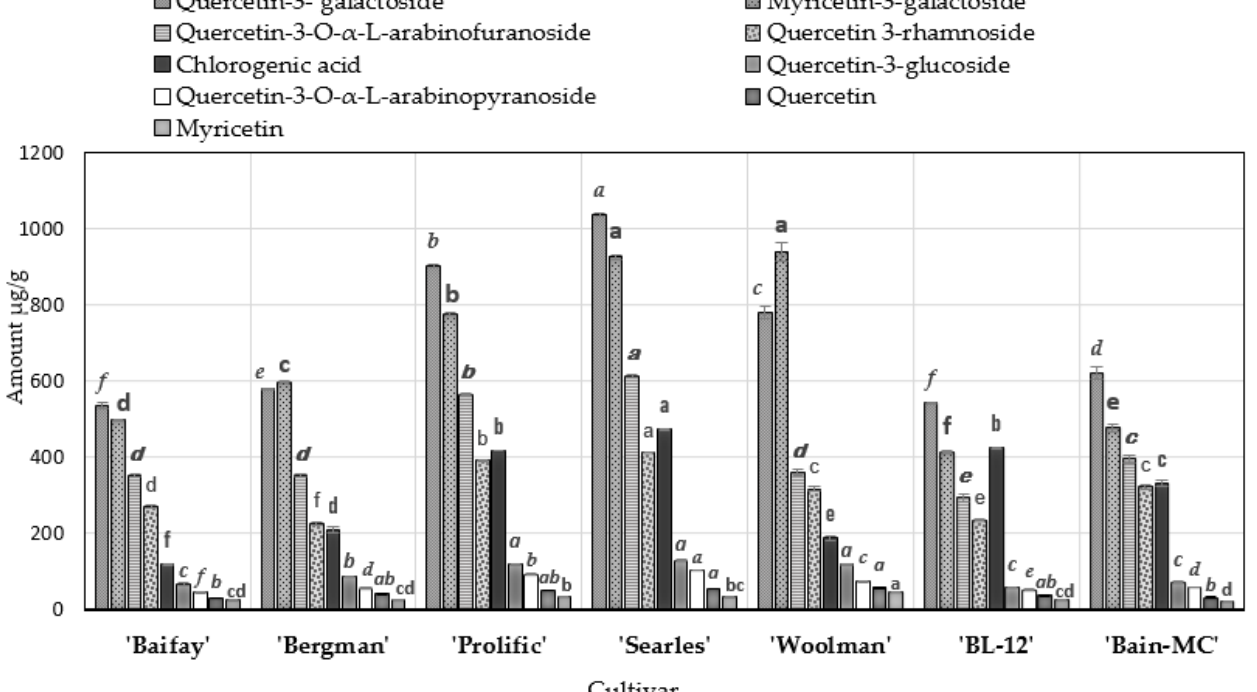
Figure 2. Variation in the amounts of phenolic compounds in fruit samples of American cranberry cultivars. Letters of different fonts and sizes indicate statistically significant differences between fruit samples of different cranberry cultivars ( p < 0.05).